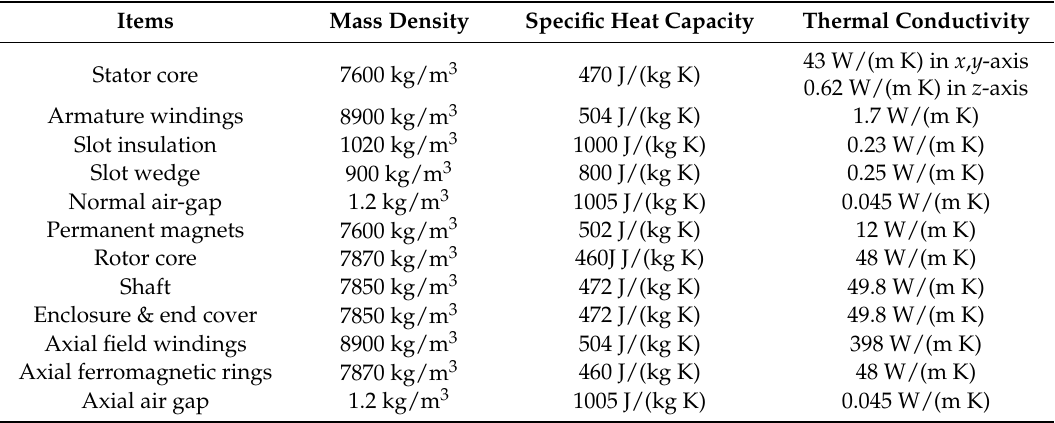
Table 4. Material properties for thermal field analysis.